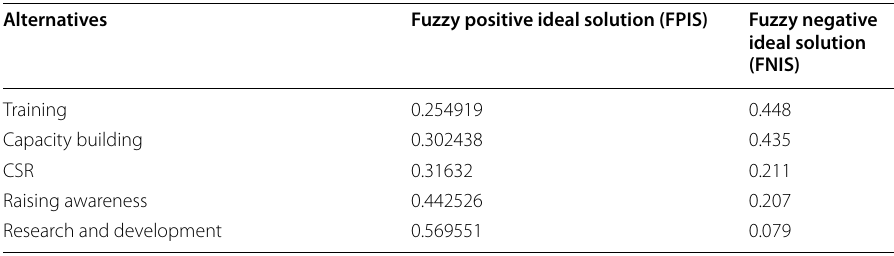
Table 19 The distance measurement Alternatives